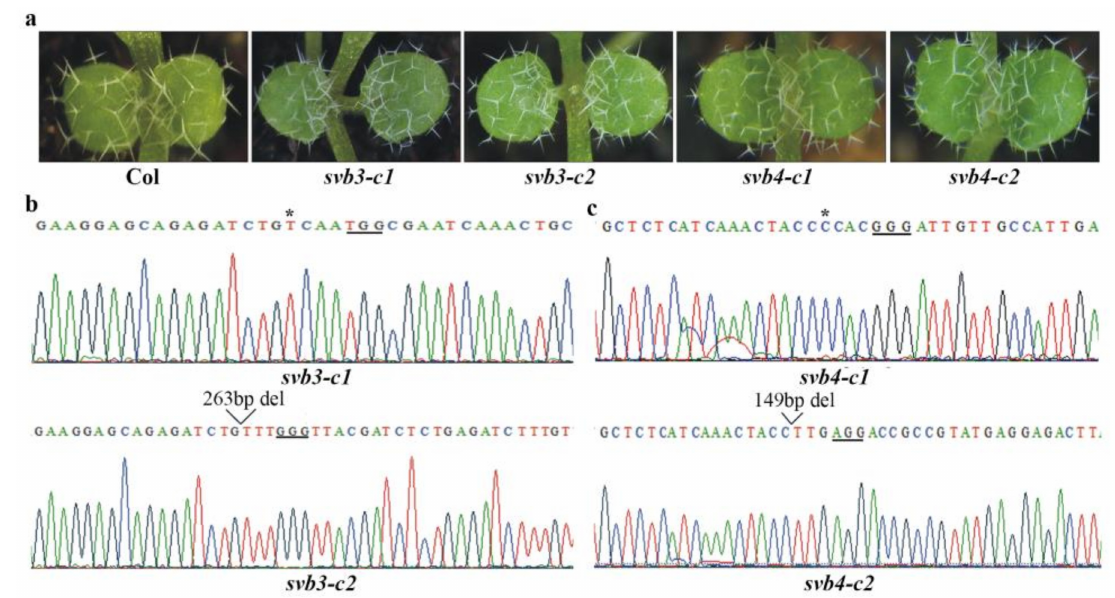
Figure 4. Mutations of SVB3 or SVB4 did not affect trichome development. ( a ) Trichome phenotypes of the Col wild type, the svb3 and svb4 single mutants. Seeds of the Col wild type, the svb3-c1 , svb3-c2 , svb4-c1 and svb4-c2 mutants were sown directly into soil pots and grown in a growth room, and trichome phenotypes on the first two rosette leaves of 8-day-old seedlings were examine under a Motic K microscope and pictures were taken by using an EOS 1100D digital camera connected to the microscope. ( b ) Editing status of SVB3 in the svb3-c1 and svb3-c2 mutants. DNA was isolated from normal flowering T2 plants, and sequenced. Underlines indicate the PAM sites, star indicates the single nucleotide insertion in the target sequence, and open arrow head indicates the site where a small fragments was deleted. ( c ) Editing status of SVB4 in the svb4-c1 and svb4-c2 mutants. DNA was isolated from normal flowering T2 plants, and sequenced. Underlines indicate the PAM sites, star indicates the single nucleotide insertion in the target sequence, and open arrow heads indicate the sites where small fragments were